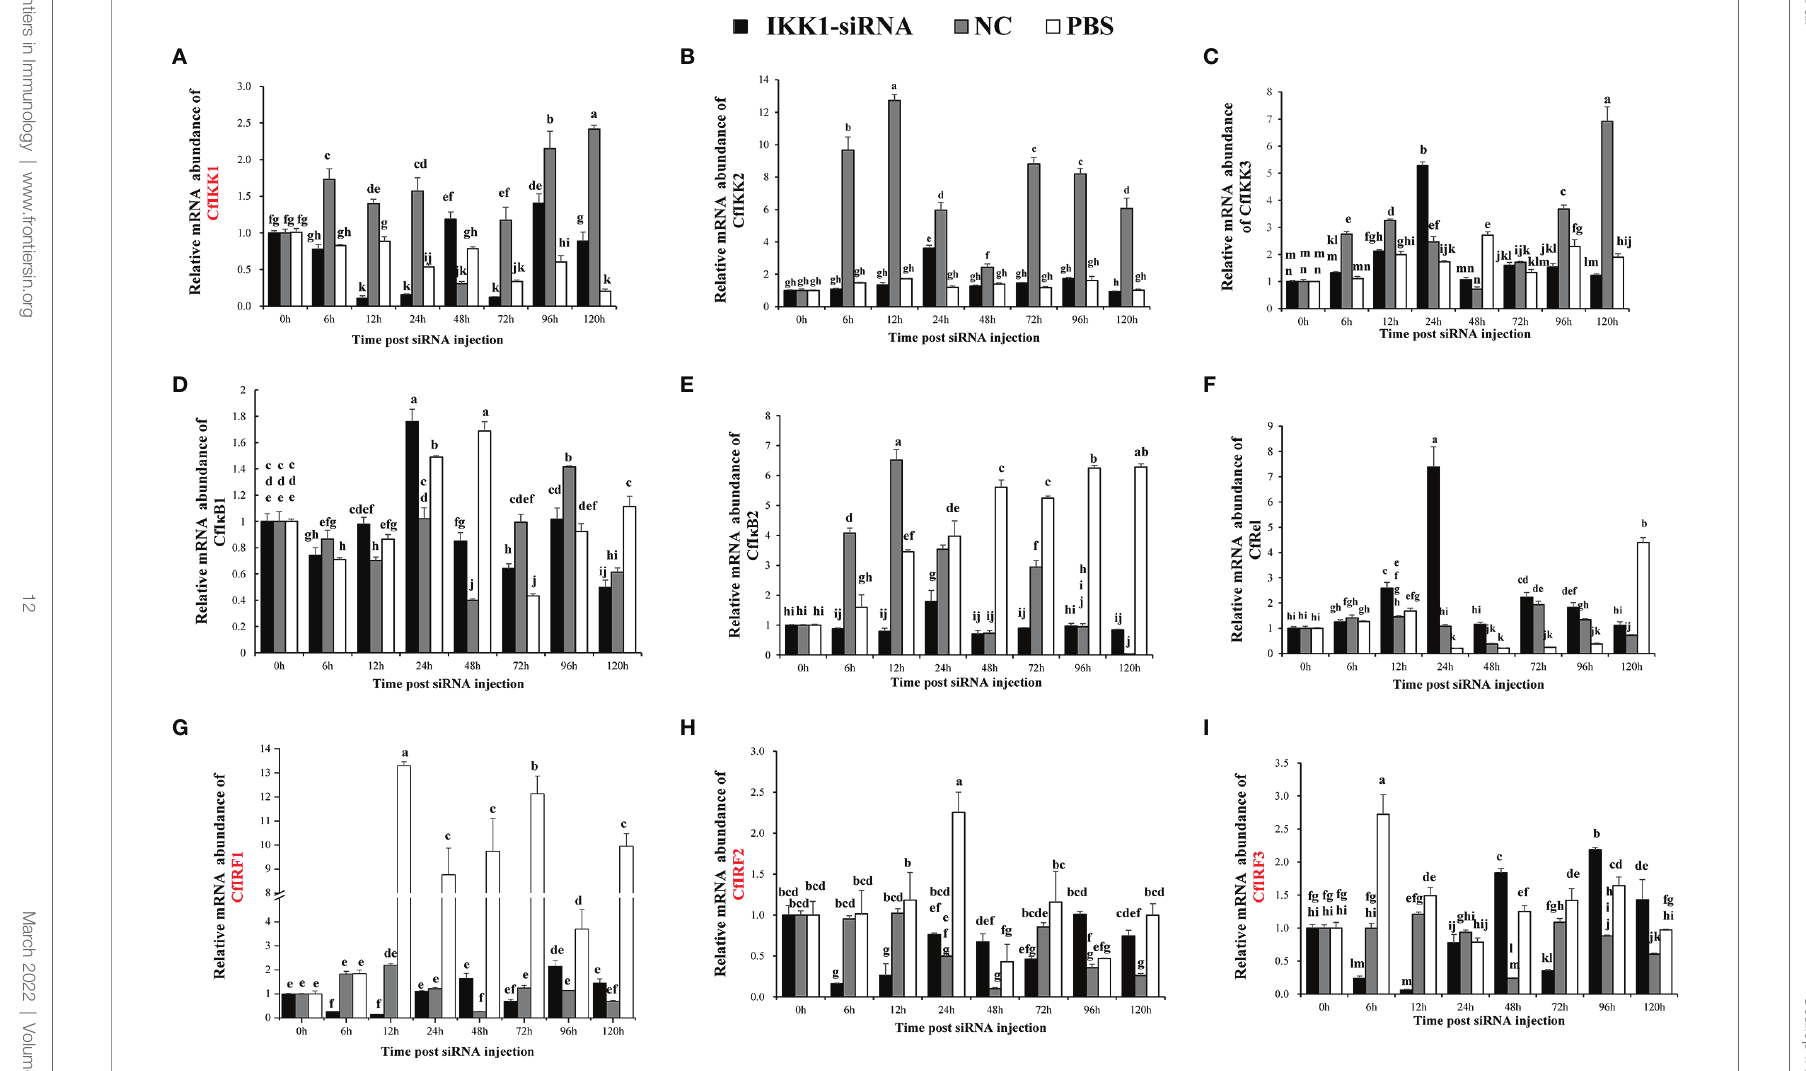
FIGURE 9 | Study on the mRNA abundance of genes related to the toll-like receptor (TLR) signaling pathway in C. farreri during CfIKK1 RNAi: (A) CfIKK1 , (B) CfIKK2 , (C) CfIKK3 , (D) CfI k B1 , (E) CfI k B2 , (F) CfRel , (G) CfIRF1 , (H) CfIRF2 , (I) CfIRF3 . CfIKK1 -siRNA was designed based on the gene sequence of CfIKK1 . And the sequence of negative control (NC) siRNA is taken from the genome of Caenorhabditis elegans , and it has no homology with Chlamys farreri after sequence alignment. Gill tissue was sampled for total RNA extraction and gene expression studies. The EF-1 a gene was used as an internal control to calibrate the gene expression of all samples. Each vertical bar represents the mean ± SD (n = 3). Different letters indicate that the differences are signi fi cant ( p < 0.05). The genes whose expression was signi fi cantly decreased after CfIKK1 -RNAi were marked in